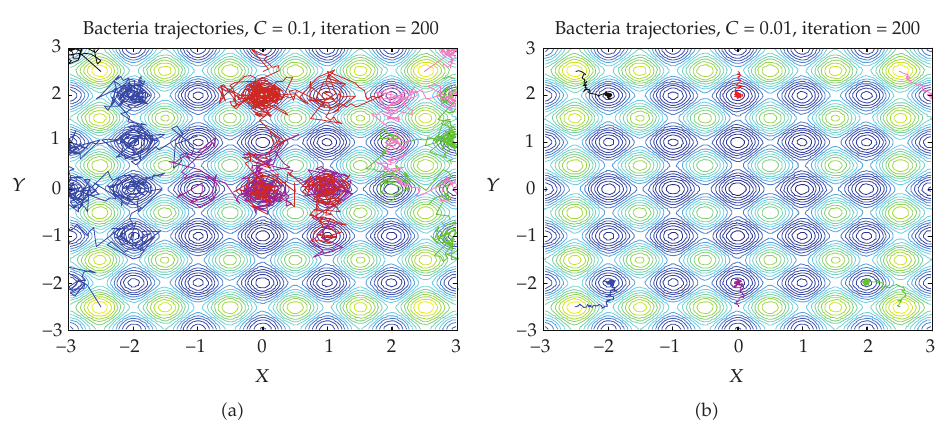
Figure 2: Bacterial Foraging trajectories on the 2D Rastrigrin